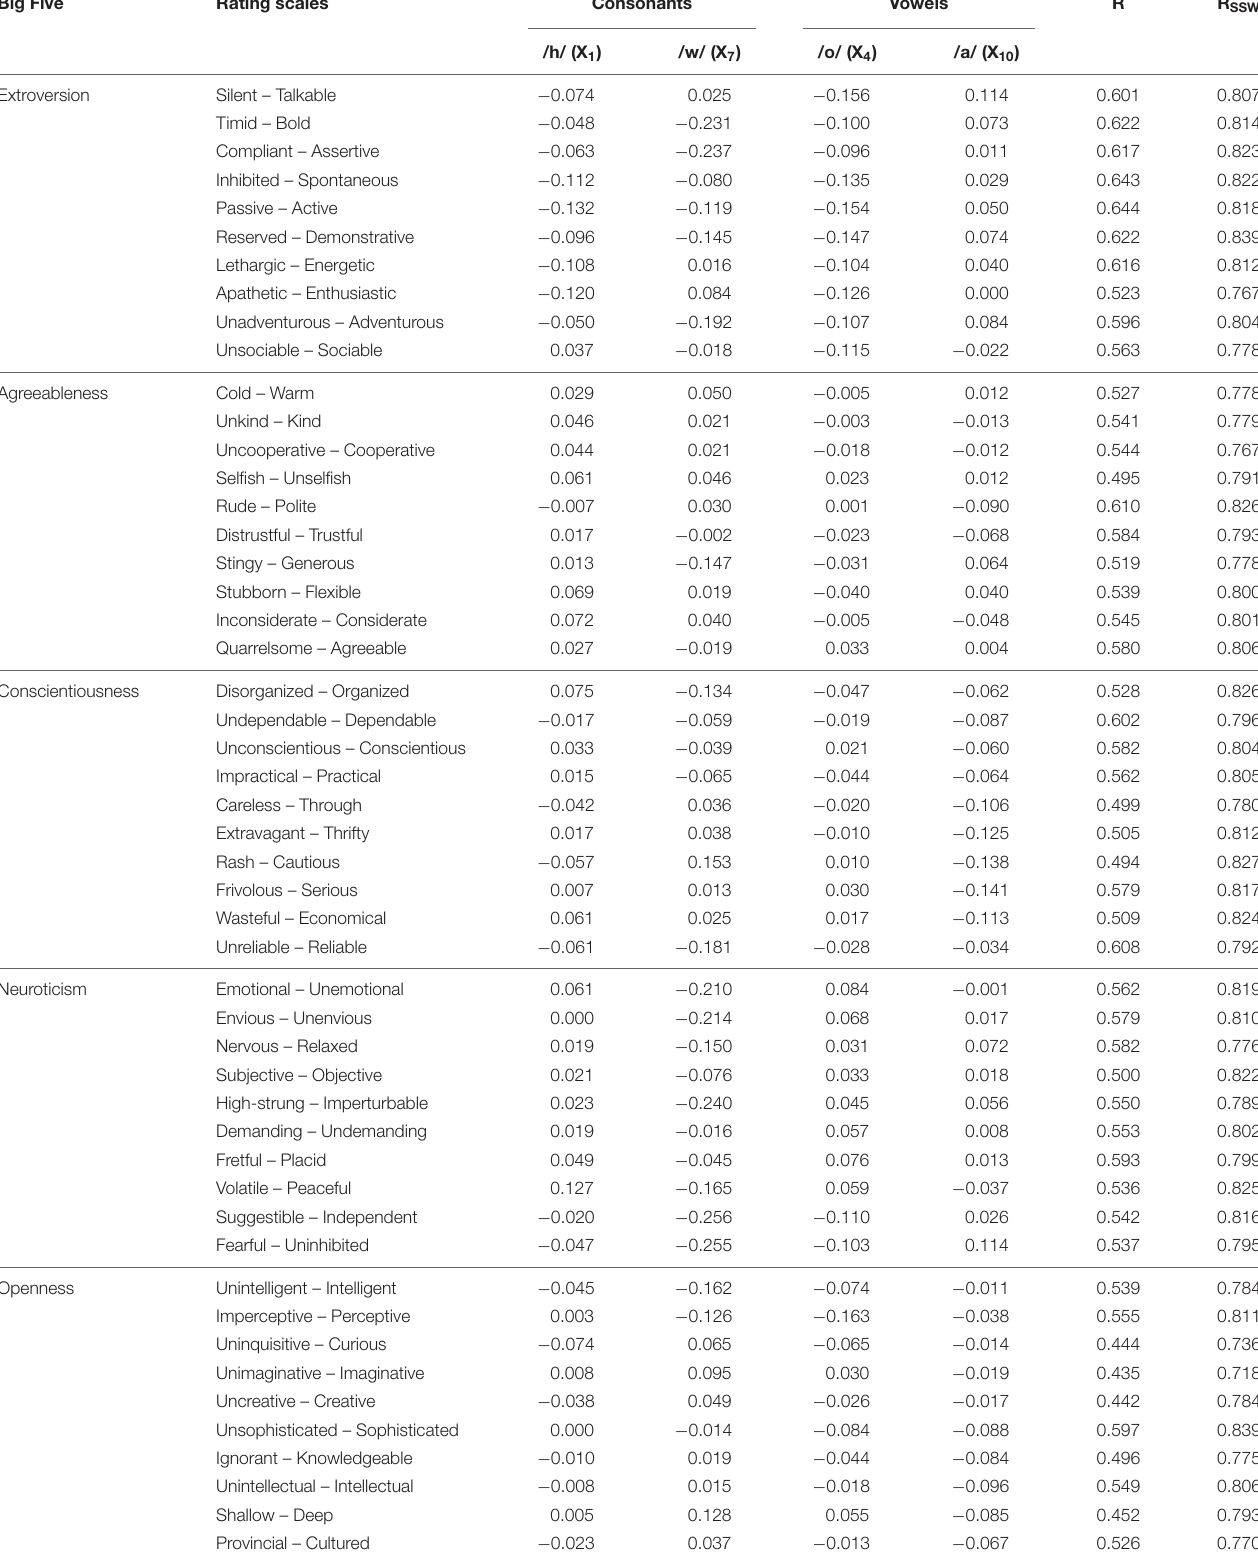
TABLE 2 | Fifty rating scales for evaluating personality, with examples of values for “howa”. Big Five Rating